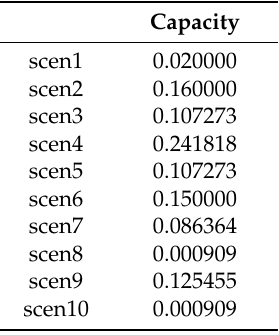
Table A21. Probabilities for each of the wind scenarios: prob(scen).